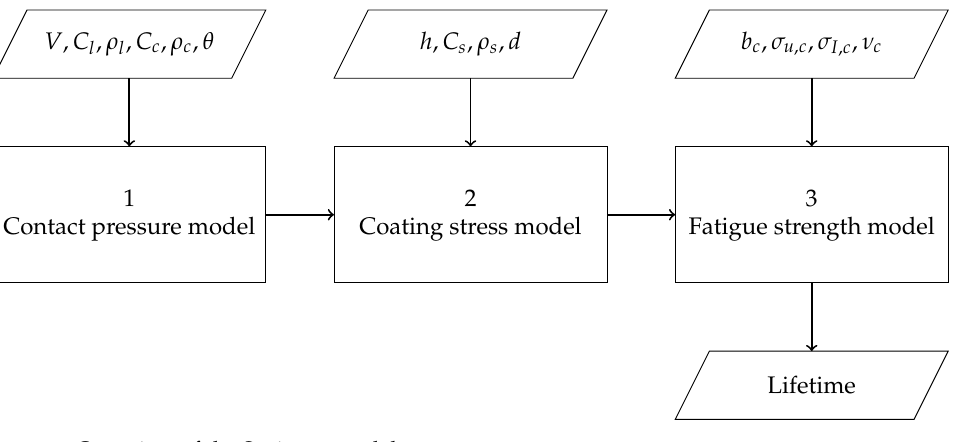
Figure 2. Overview of the Springer